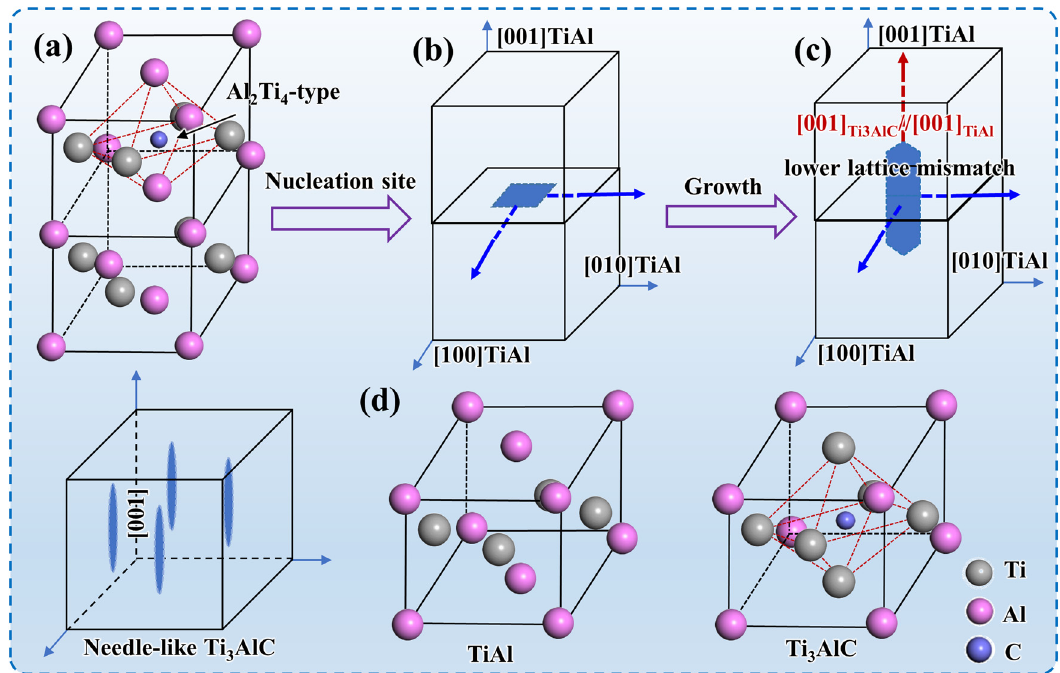
Figure 9: The schematic illustration for the nucleation and growth mechanism of Ti 3 AlC nano - precipitates: ( a ) the atomic model of TiAl ( C ) solid solution with Al 2 Ti 4 - type octahedral interstice; ( b ) the nucleation of Ti 3 AlC; ( c ) the growth of Ti 3 AlC; and ( d ) the atomic model of TiAl and Ti 3